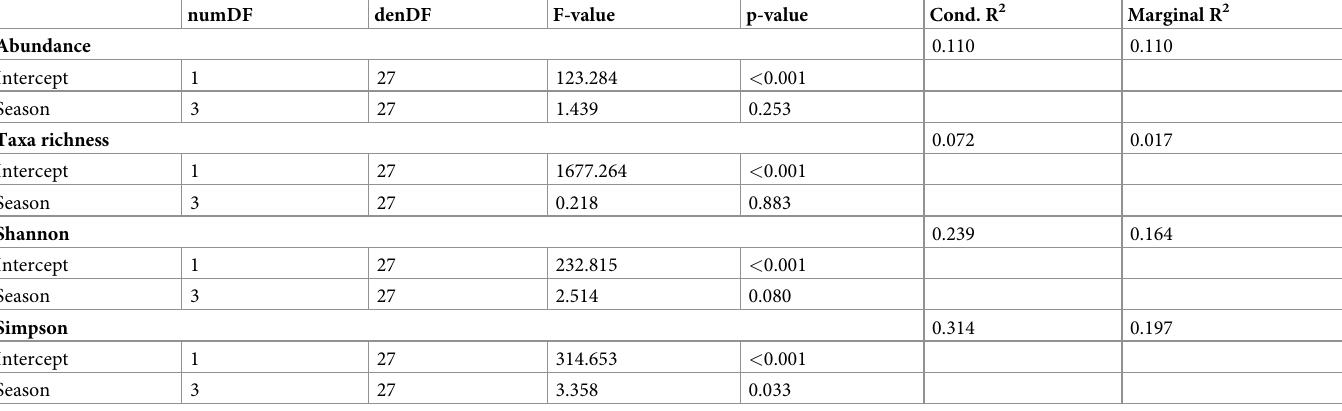
Table 1. Results of linear mixed-effects models on the effect of season (spring, summer, fall, winter) on the abundance and diversity of soil communities sampled from soil